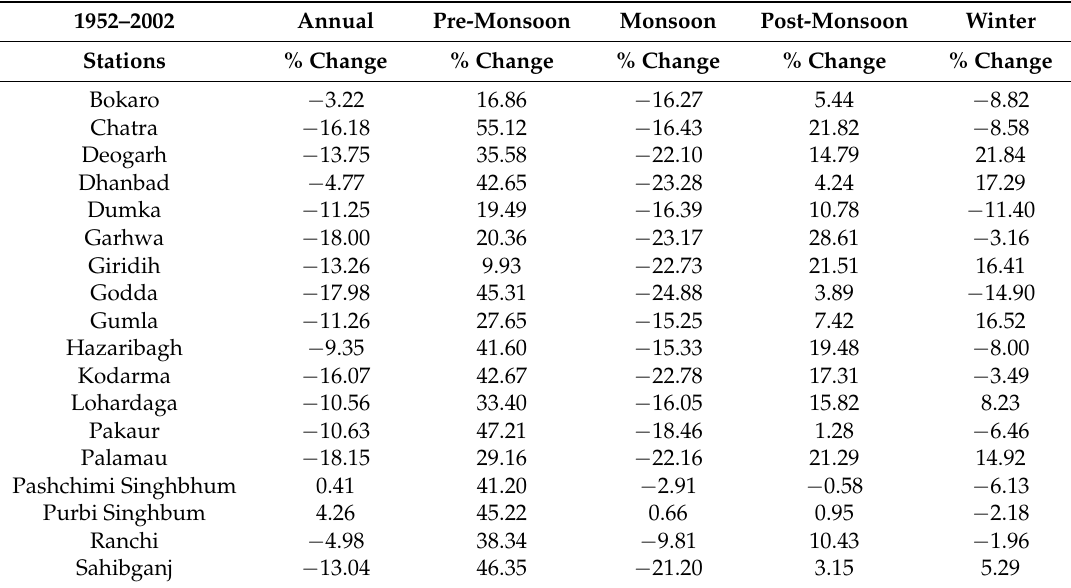
Table 5. Percent change of Annual and Seasonal rainfall